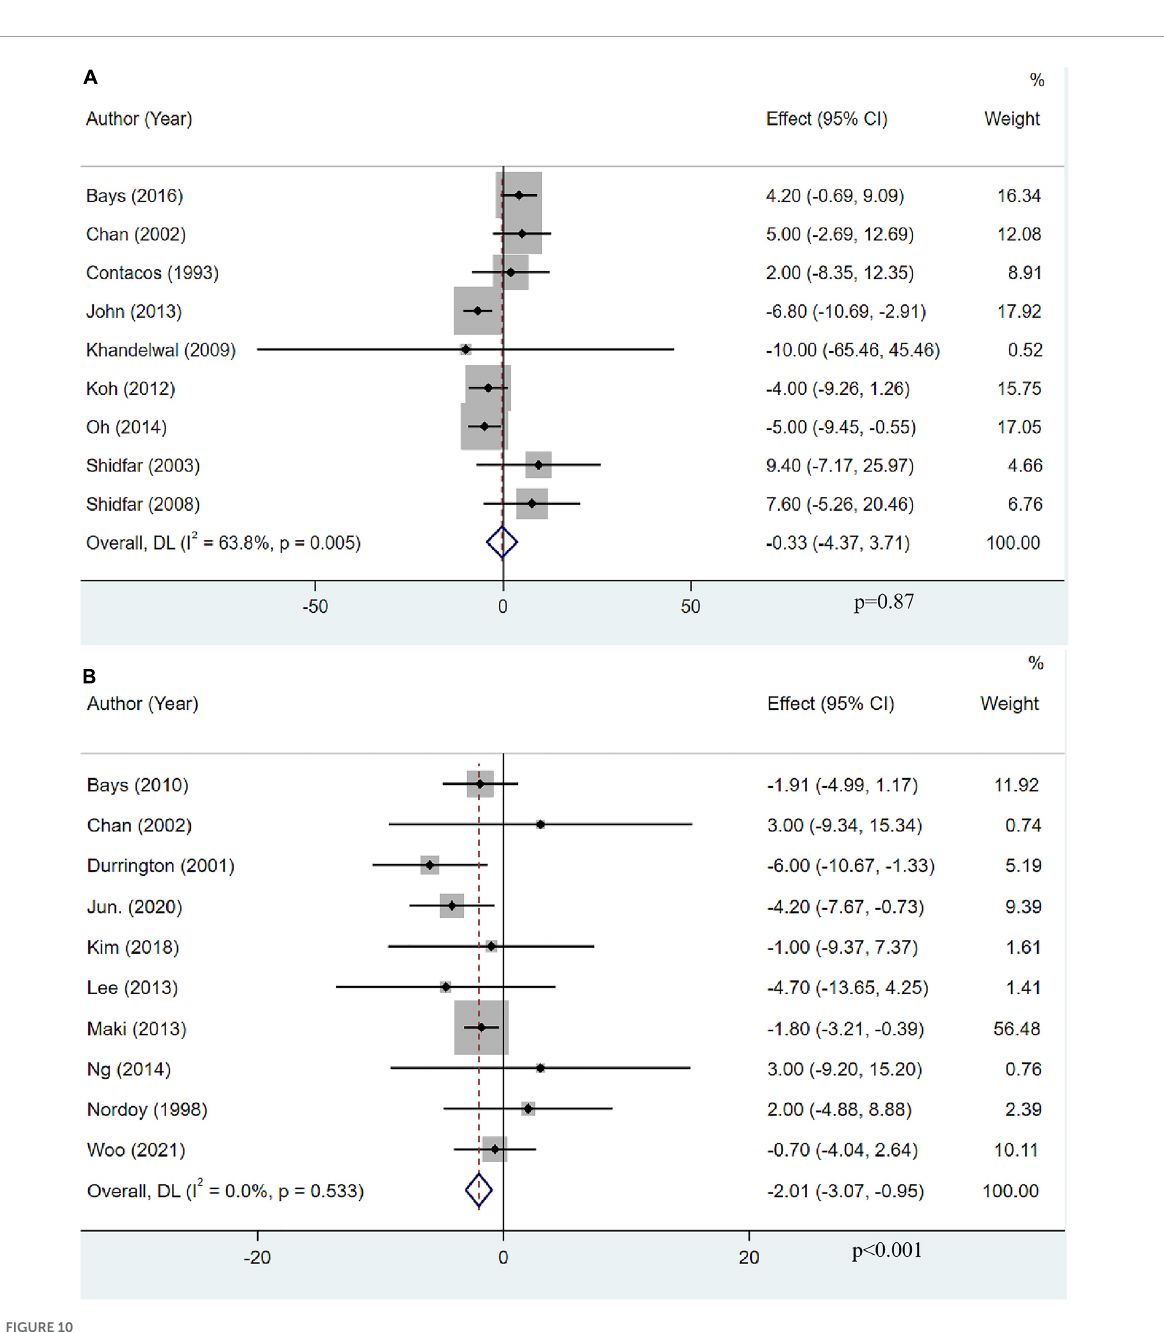
Apo B-containing LDL and VLDL is accelerated when OM3- FA is co-administrated (58). However, why the level of Apo- AI decreased after OM3-FA was added to statins needs to be further explored. Since combination therapy with OM3-FA and statins reduced Apo-B and Apo-AI simultaneously, the ratio may not change much. Therefore, we thought that combination therapy for the treatment of hypertriglyceridemia is still